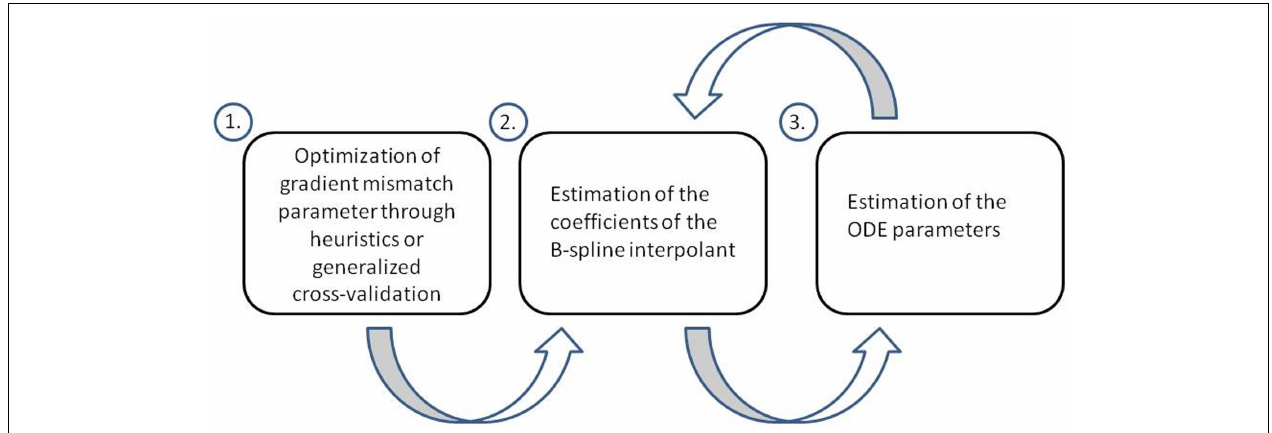
FIGURE 3 | Flow chart of the three level approach employed by Ramsay et al. (2007) . At level 1, the gradient mismatch parameter is optimized either by visual or numerical heuristics or through generalized cross-validation. At level 2, the coefficients of the interpolant are estimated (splines in this method). At level 3, the ODE parameters are estimated. Levels 2 and 3 are iterated using a pseudo-delta method (see Section 2.5 for details).